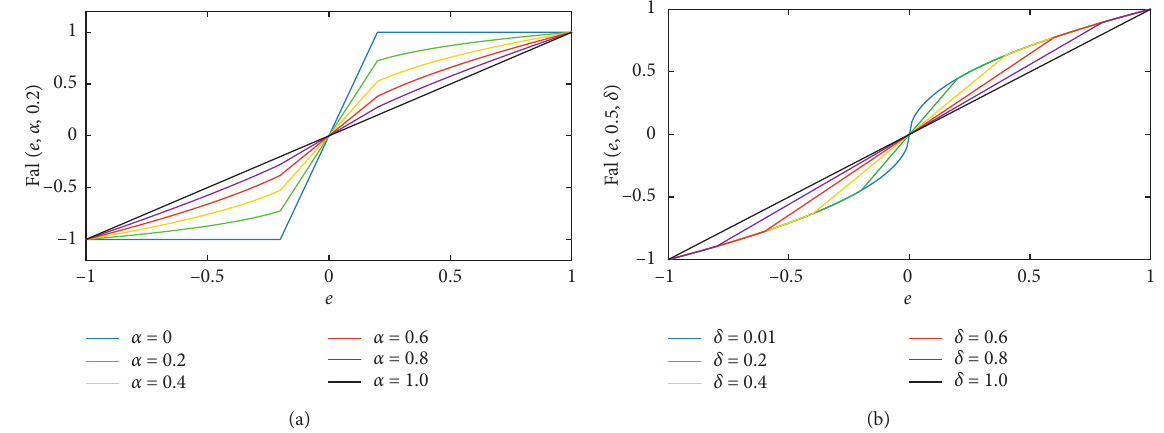
Figure 4: Properties of the Fal function with different α and δ values.